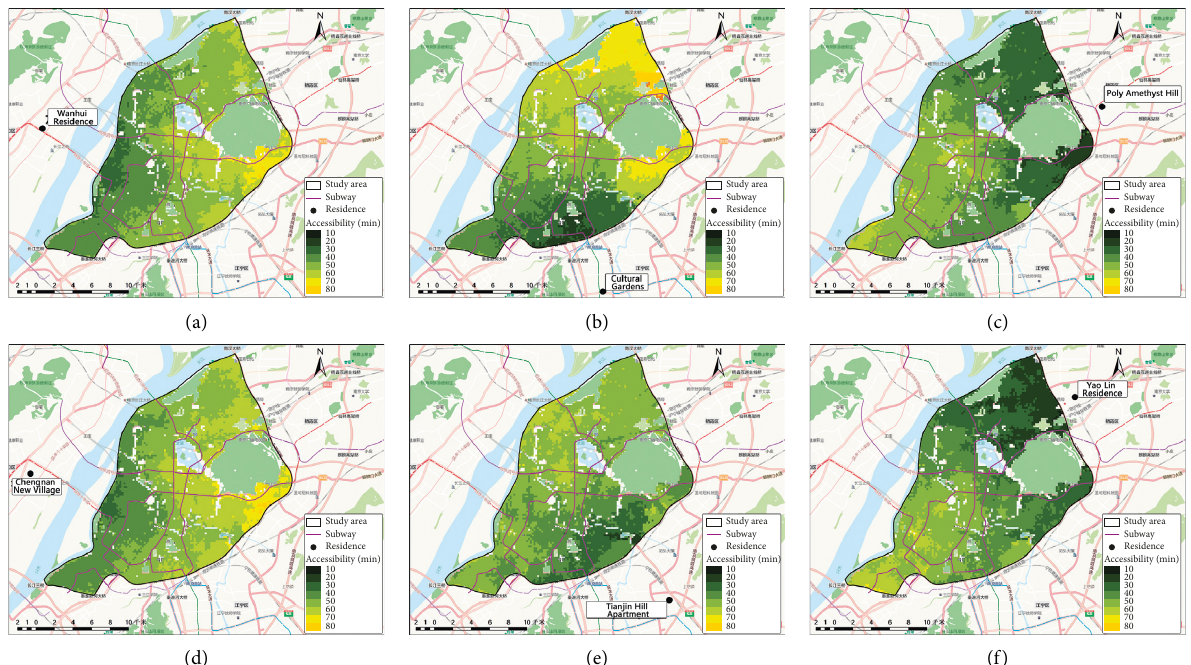
Figure 2: Access to the main city by residential areas in the morning peak on January 23 (normal weather). Commercial housing blocks: